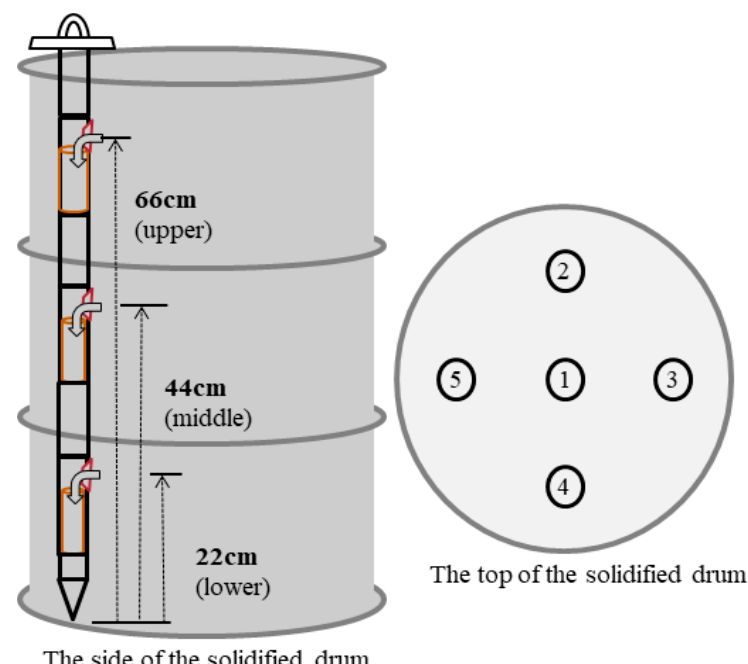
Figure 2. Five collection points on the top surface of the drum and another three points along the vertical direction (upper/middle/lower) for each collection point. Table 8. Sample codes, sample collection points, and vertical-direction positions, along with test items.